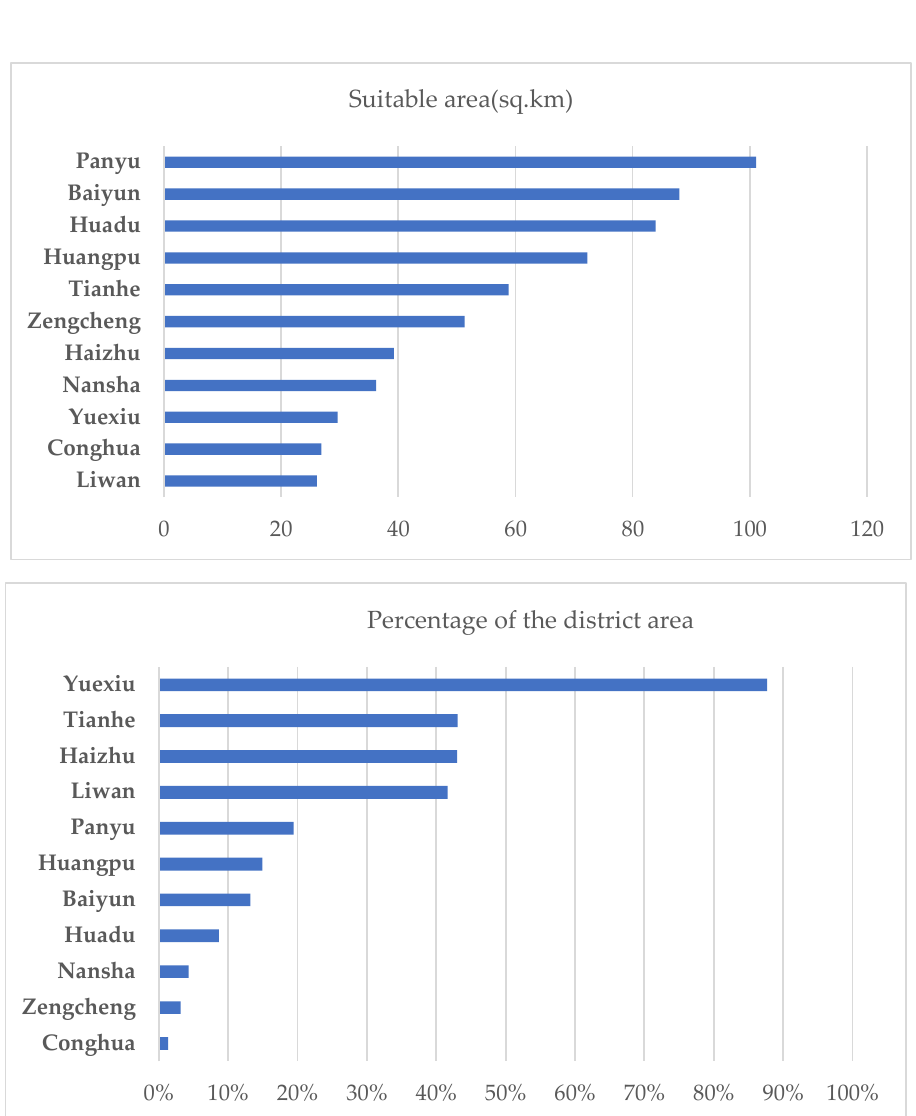
Figure 5 . Suitability map for PPLs using the best LR model.